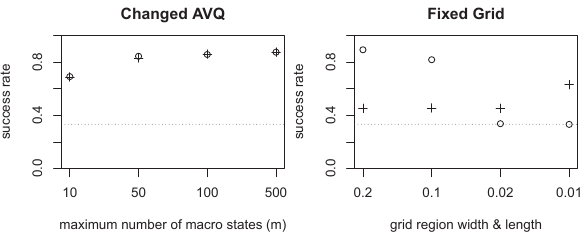
Figure 3: Success rates for the benchmark using the changed AVQ (left) and a fixed grid (right), once for the size x ∈ [0 , 2 · π ] ,y ∈ [ − 1 , 1] (circles), once for the scaled down size x ∈ [0 . 52 , 0 . 54] ,y ∈ [0 . 39 , 0 . 41] (crosses). The dotted lines show the success rate of a random choice, i.e., 1 3